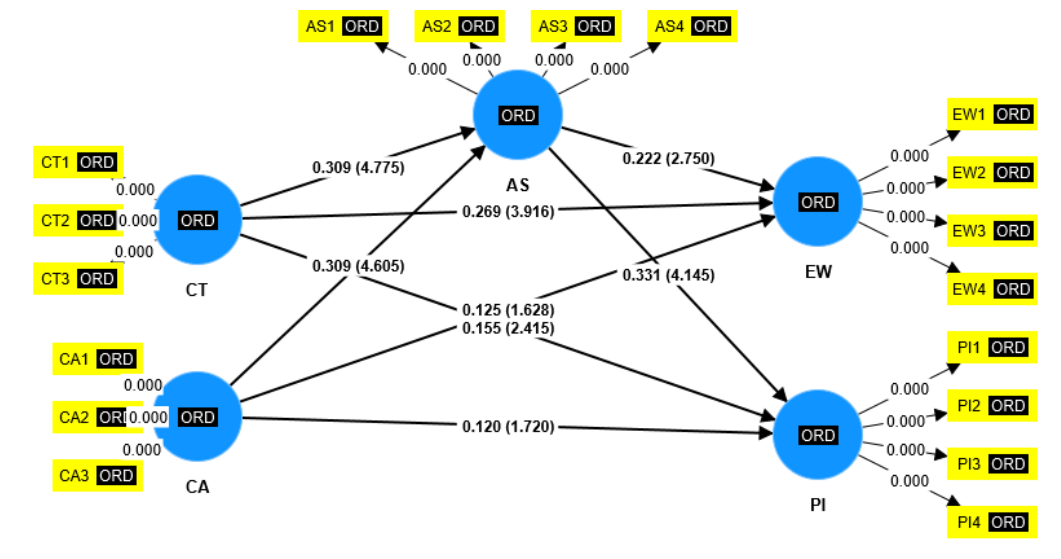
Figure 4. Path coefficient with t-values.